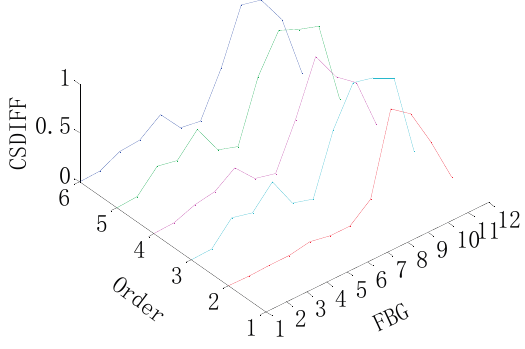
Figure 7. CSDFIF for the single-damage detection.